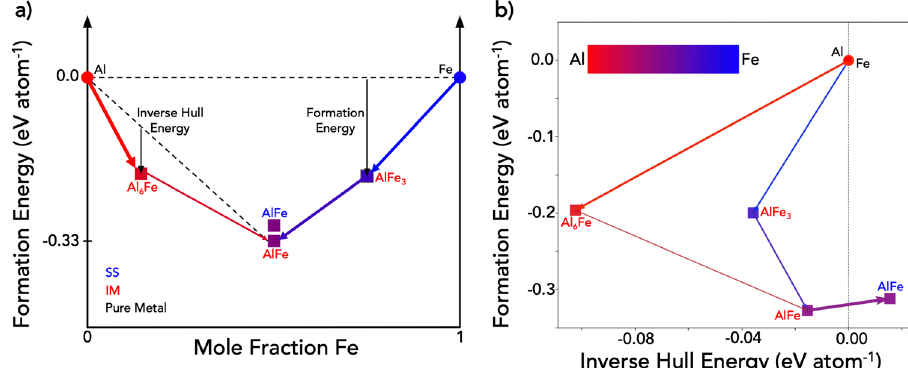
Fig. 1 Conversion of the convex hull to Inverse Hull Web. a Convex Hull of Al − Fe system at 1250 K, with formation energy on the y -axis and mole fraction Fe on the x -axis. The dotted line connecting Al and AlFe demonstrates the process for fi nding Al 6 Fe ’ s hull reactants and inverse hull energy. The arrow width representation of phase fraction is shown as the arrow connecting Al 6 Fe to Al is thicker than the arrow connecting Al 6 Fe to AlFe. b Inverse hull web of Al − Fe system at 1250 K, with formation energy on the y -axis and inverse hull energy on the x - axis. The AlFe solid-solution lies to the right of the dotted line, indicating it is metastable with respect to an AlFe intermetallic. The code used to generate Inverse Hull Webs can be found in Supplementary Data